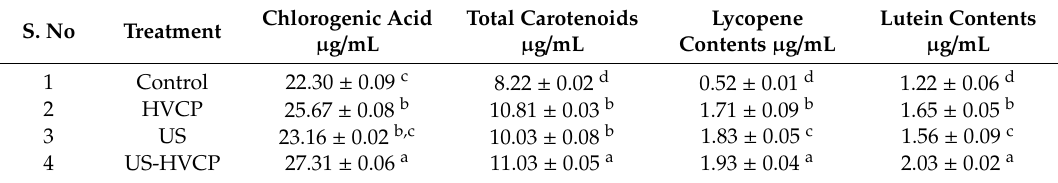
Table 2. Combined e ff ect of treatments on di ff erent quality